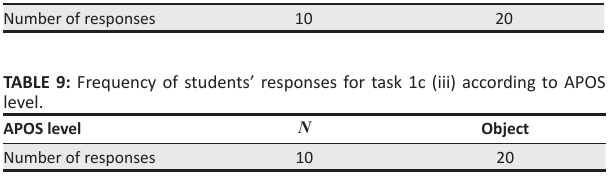
TABLE 8: Frequency of students’ responses for task 1c (ii) according to APOS level. APOS level